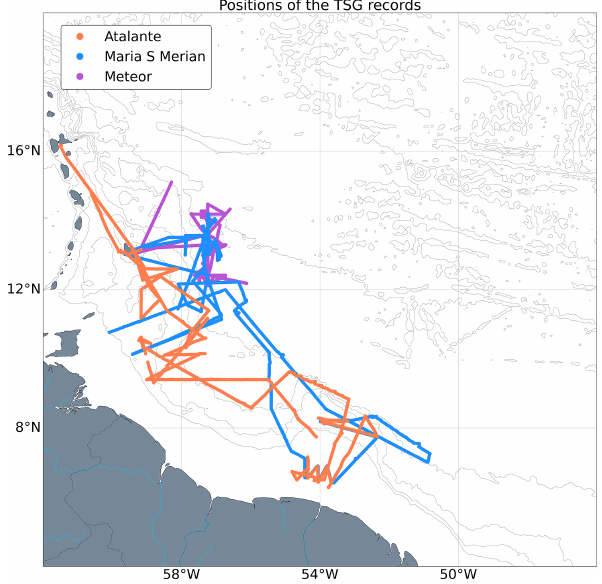
Figure 8. Map of the TSG records performed by R/Vs L’Atalante , Maria S. Merian , and Meteor